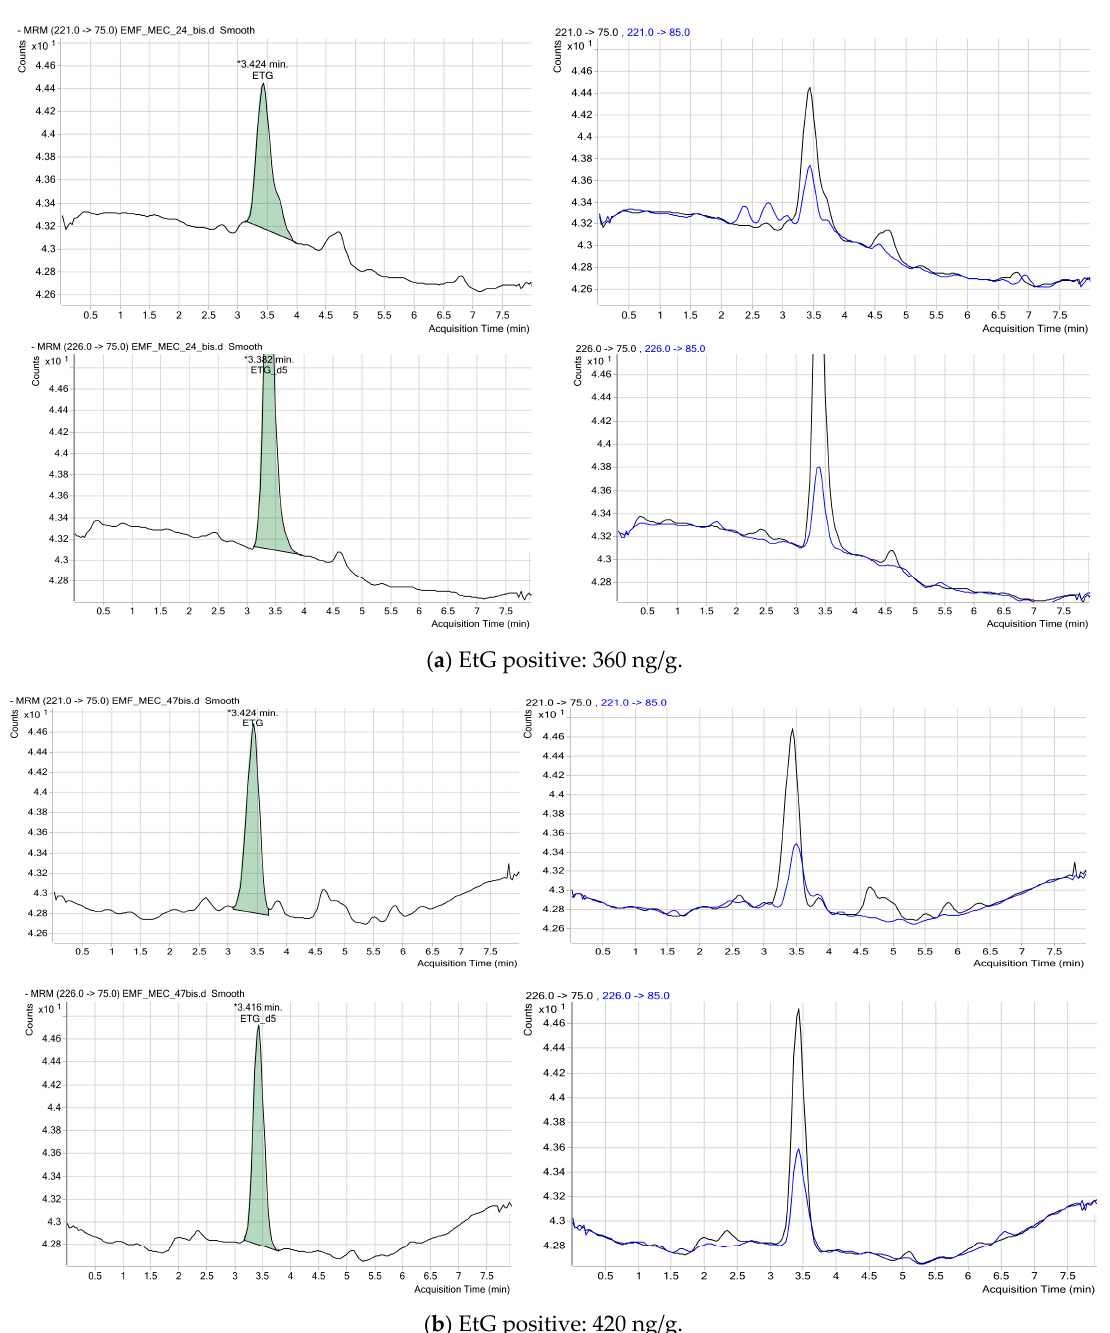
Figure 2. Chromatogram in two meconium samples testing positive for EtG. The retention time of substance ranged from 3 to 3.5 min depending on the column life span. The black line depicts the quantitative transitions and the blue line depicts the qualitative transitions. The green shade represents the quantification of EtG using the calibration curves. The “multiple reaction monitoring” (MRM) program takes into account the following transitions: EtG quantifier 221 > 75 and qualifier 221 > 85, internal standard (EtG-d5) quantifier 226 > 75 and qualifier 226 > 85. ( a ) sample EMF_MEC_24 with a positive concentration of 360 ng/g; ( b ) sample EMF_MEC_47 with a positive concentration of 420 ng/g.